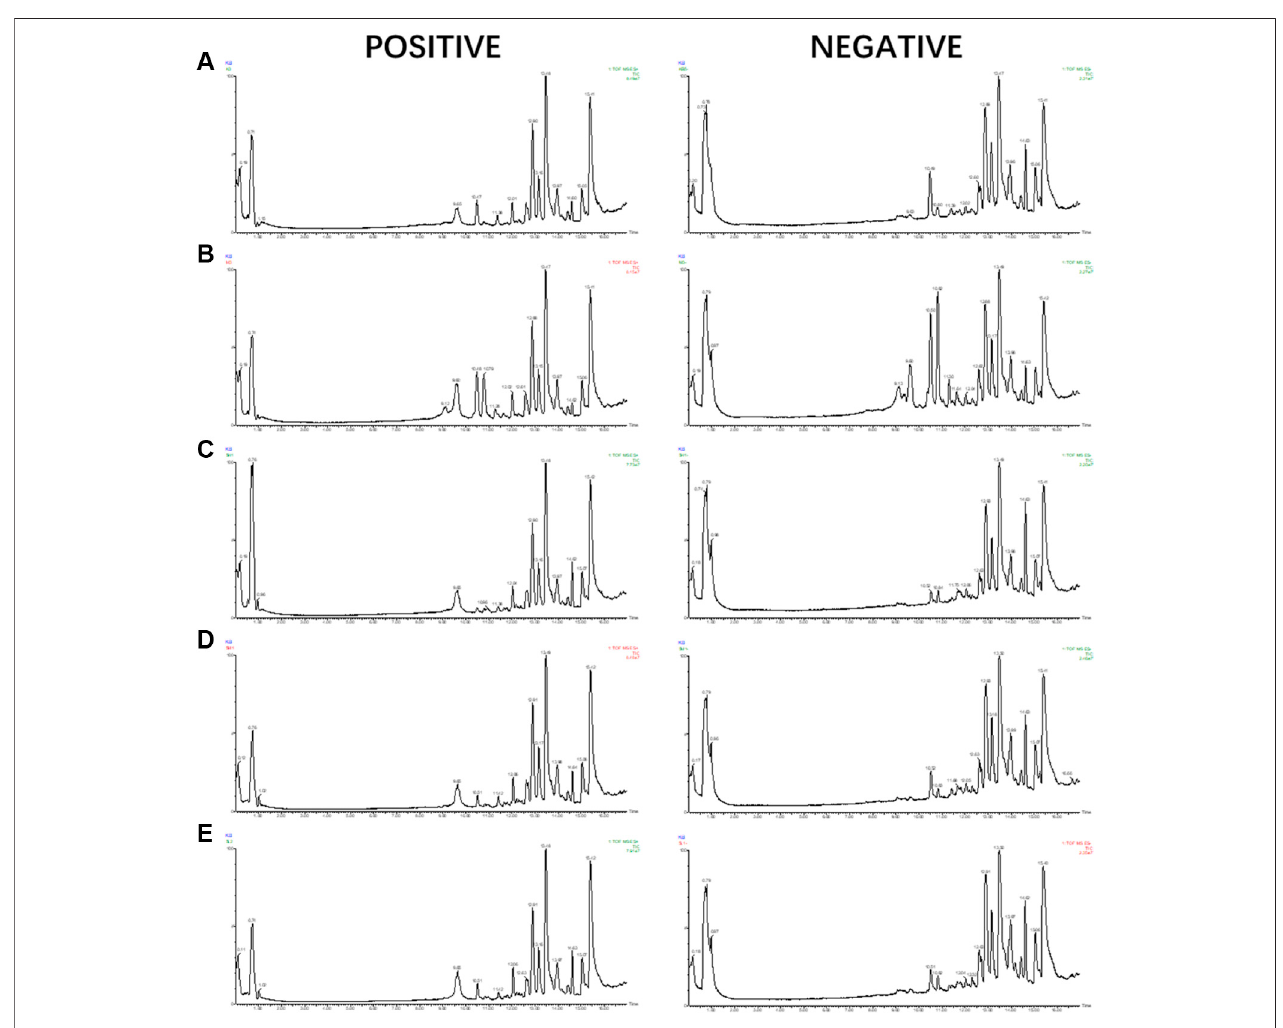
FIGURE 5 | UPLC-MS/MS TIC diagram: (A) Control group, (B) Model group (C) 5-HMF-H group, (D) 5-HMF-M group, (E) 5-HMF- L group.